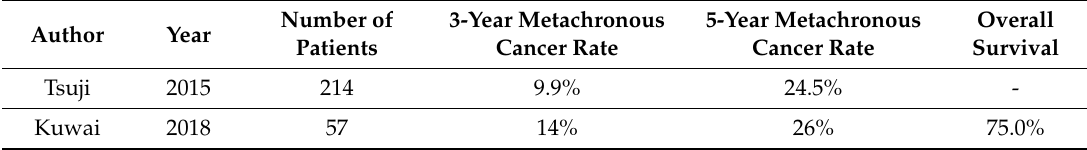
Table 6. Cumulative metachronous cancer rate after complete resection in esophageal endoscopic submucosal